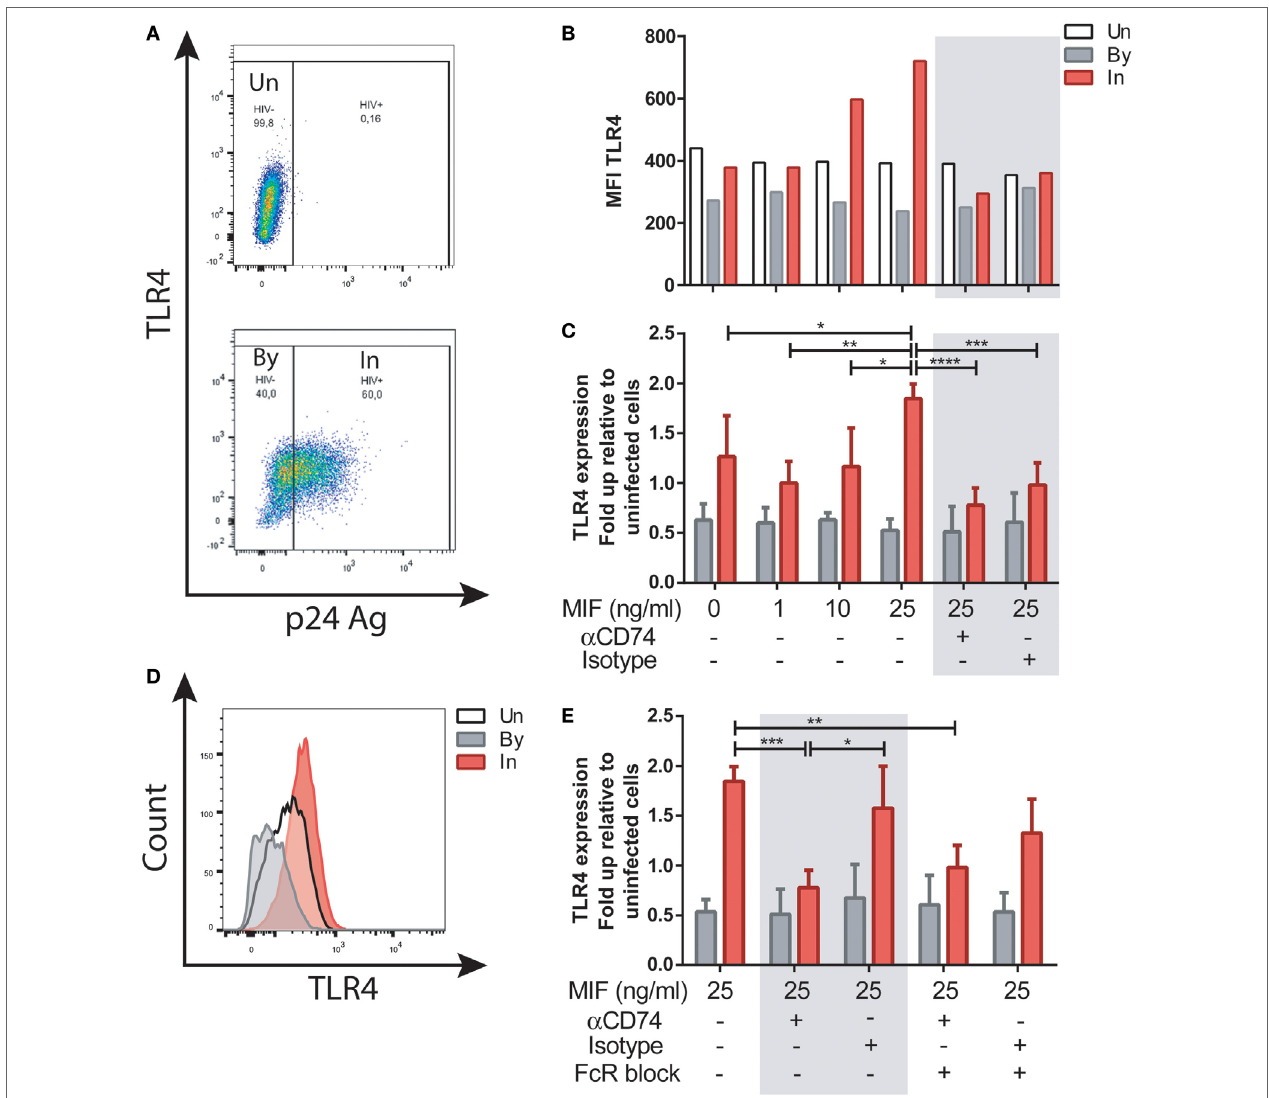
FigUre 3 | TLR4 expression after macrophage migration inhibitory factor (MIF) stimulation in primary human immunodeficiency virus (HIV)-infected monocyte- derived macrophages (MDMs). (a) TLR4 expression in uninfected (UN, upper panel), bystander (By, lower panel), and productively infected cells identified on the bases of intracellular p24 staining (In, lower panel). Living MDMs were gated previously on a forward scatter versus side scatter dot plot. An isotype-matched FITC-conjugated antibody was used to accurately set the p24-negative population. (B) TLR4 MFI in uninfected MDMs (Un), in productively infected MDMs (p24 positive population within the well inoculated with the virus, In) and in the bystander uninfected MDMs (p24-negative population within the well inoculated with the virus, By) after MIF treatment. These data represent the results obtained from one representative donor. (c) Ratio between the TLR4 MFI of the infected (or bystander population) and the TLR4 MFI of the uninfected cells after treatment with MIF, with or without CD74 blockade with an anti-CD74 antibody. Fold up from four independent donors, evaluated in duplicate are shown collectively. Data represent the mean ± SD. (D) Flow cytometry histogram overlay for TLR4 expression on Un, By, and In MDMs all treated with 25 ng/ml MIF (e) Ratio between the TLR4 MFI of the infected (or by-stander population) and the TLR4 MFI of the uninfected cells using the different CD74-blocking conditions represented in the x -axis. Data were analyzed by two-way ANOVA followed by Tukey’s post-test. * p < 0.05, ** p < 0.01, *** p < 0.001, **** p <